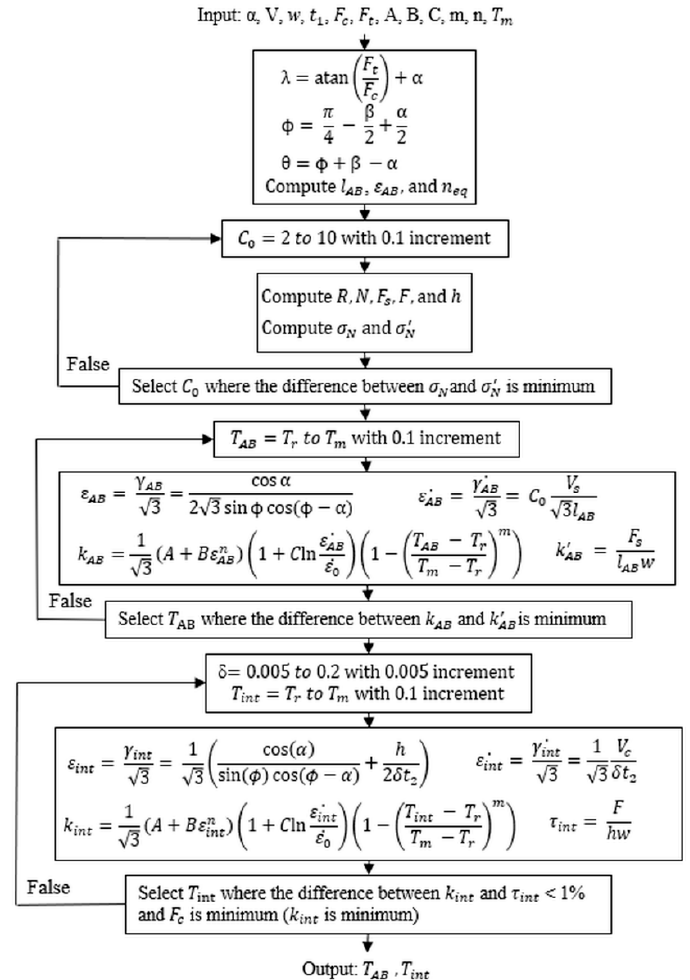
Figure 2. The algorithm of temperature predictions in the presented model.